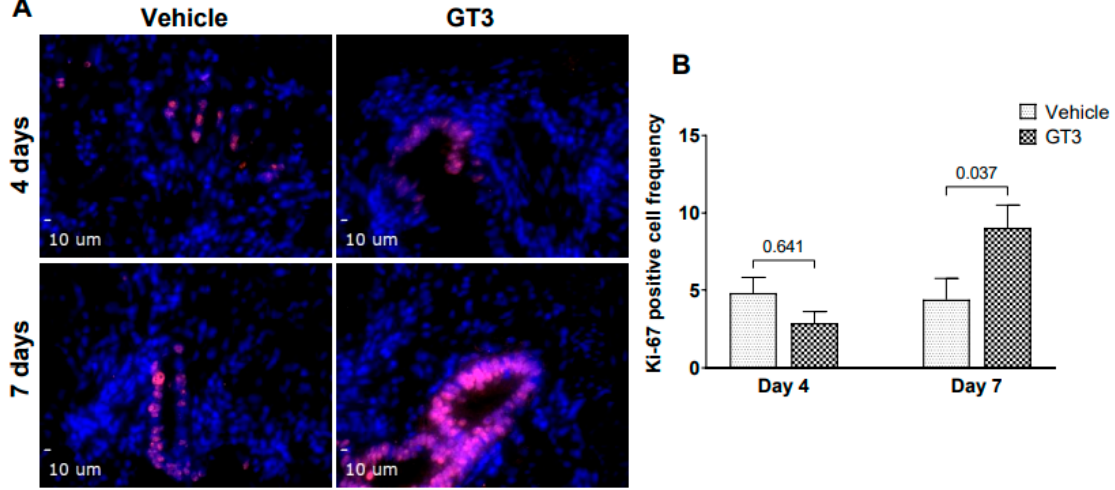
Figure 4. Effects of GT3 on intestinal stem proliferation as assessed by Ki-67. ( A ) Representative photomicrograph of Ki-67-positive cells (red) in the crypts. ( B ) Mean fluorescence intensity of Ki-67 at day 4 and 7 post-TBI in vehicle and GT3-treated groups. The data are presented as average ± SEM; N = 3 (day 4) and N = 5 (day 7).